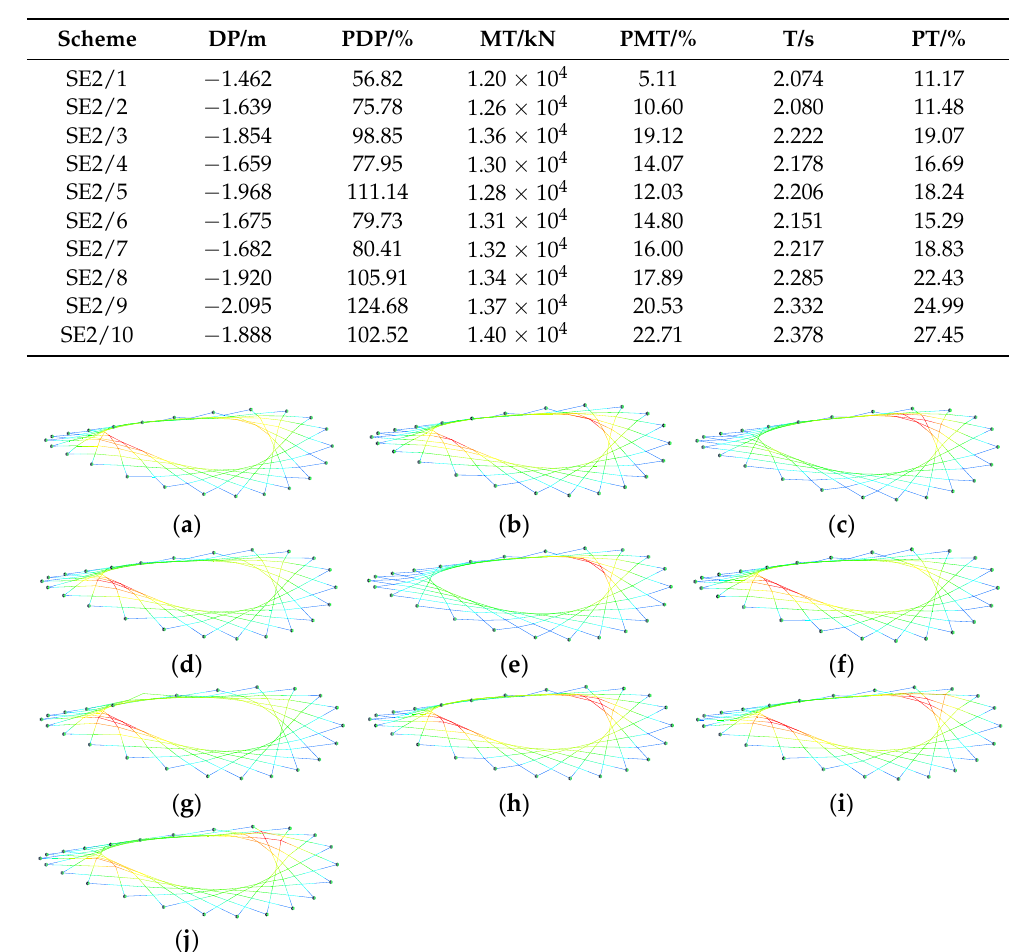
Table 4. Results of deleting two virtual rings.